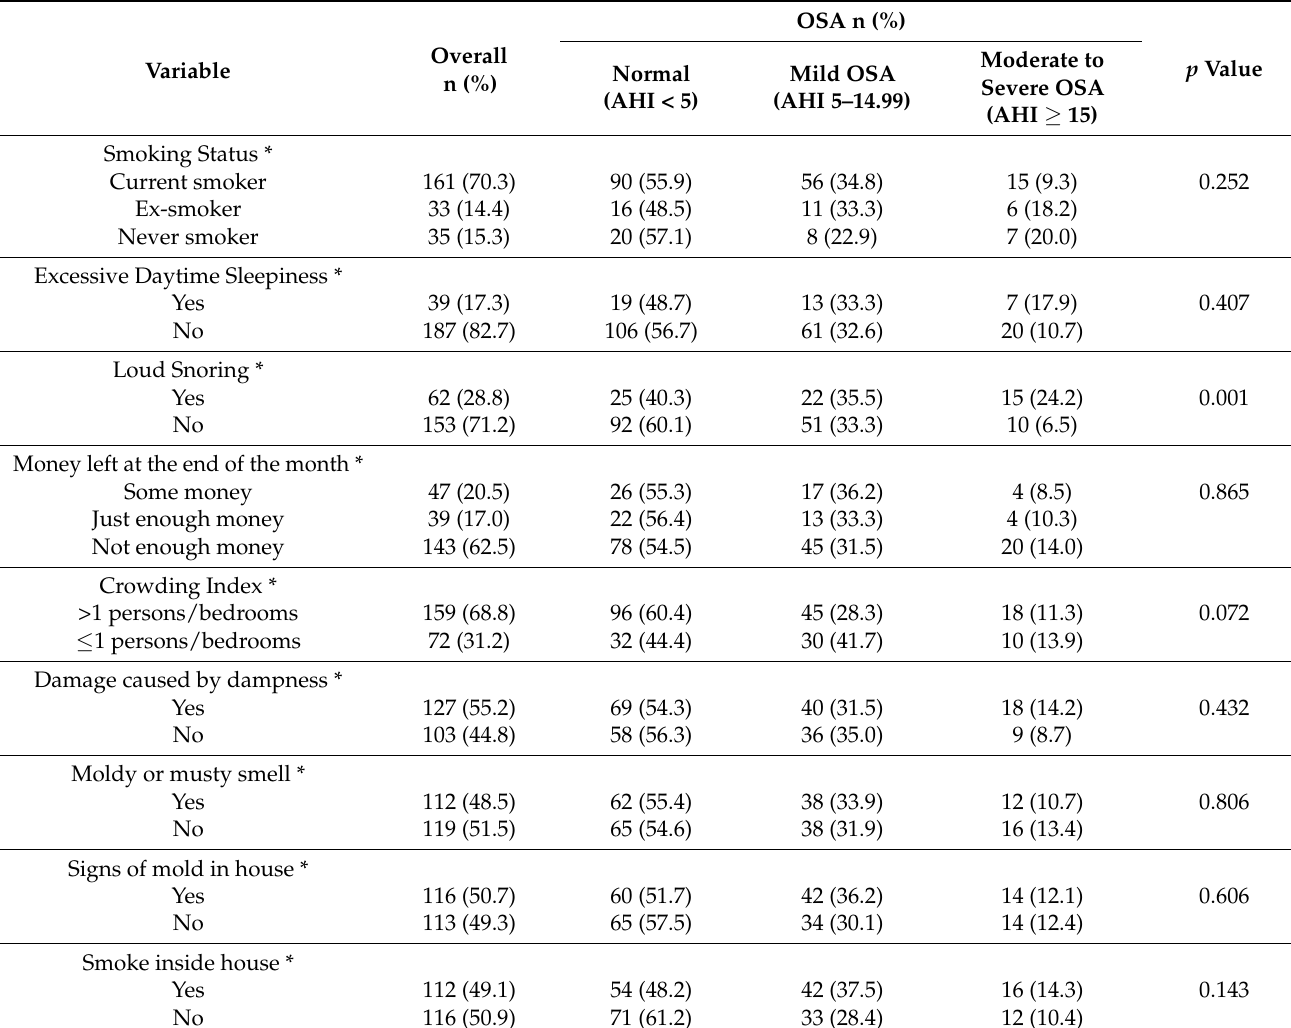
Table 2 demonstrates an ordinal logistic regression univariable model (unadjusted) which showed significant associations between high values of AHI and obesity and loud snoring. In addition, the ordinal logistic multiple regression model (adjusted) revealed that the odds of having a high AHI (mild to severe vs. normal) was 2.48 (95% CI, 1.35 to 11.90) higher for males compared to females which was statistically significant, p = 0.004. For obese individuals, the odds of having high AHI (mild to severe vs. normal) was 3.89 (95% CI, 2.10 to 49.02, p < 0.0001) times than that of non-obese participants. Participants who snored loudly were 2.14 (95% CI, 1.16 to 8.56) times the odds of those who did not snore loudly to have a high AHI (mild to severe vs. normal), which was statistically significant, p = 0.016. The test of parallel lines (Chi-Square test statistics = 7.176, degrees of freedom = 7; p = 0.411) satisfied the proportional odds assumption of the ordinal regression model. Interactions between potential effect modifiers were examined but none were